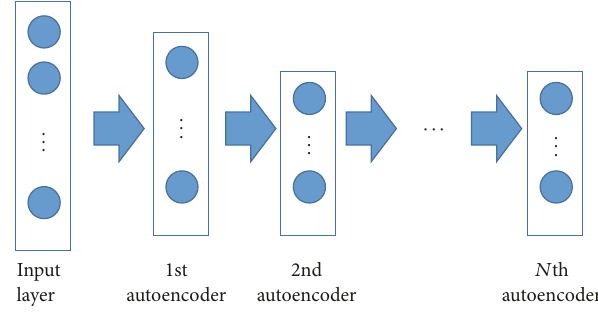
Figure 6: Stacked